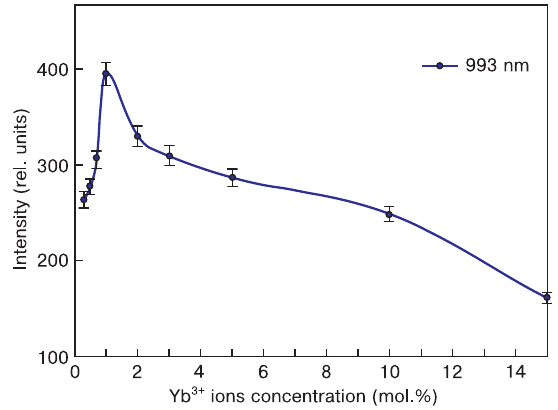
Figure 6. 993 nm luminescence band intensity of (Ca Yb Na ) Ga O ( x = y = 0.3; 0.5; 0.7; 1; 2; 3; 5; 10; 15 mol.%) 1- х - y х y 2 4 as a function of Yb 3+ ions concentration for 940 nm